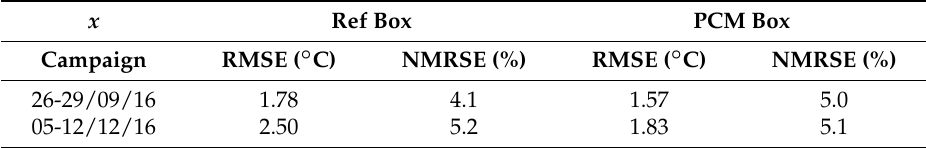
Table 6. RMSE and NMRSE between measured and simulated temperature trends for the two campaigns. RMSE and NMRSE between measured and simulated temperature trends for the two